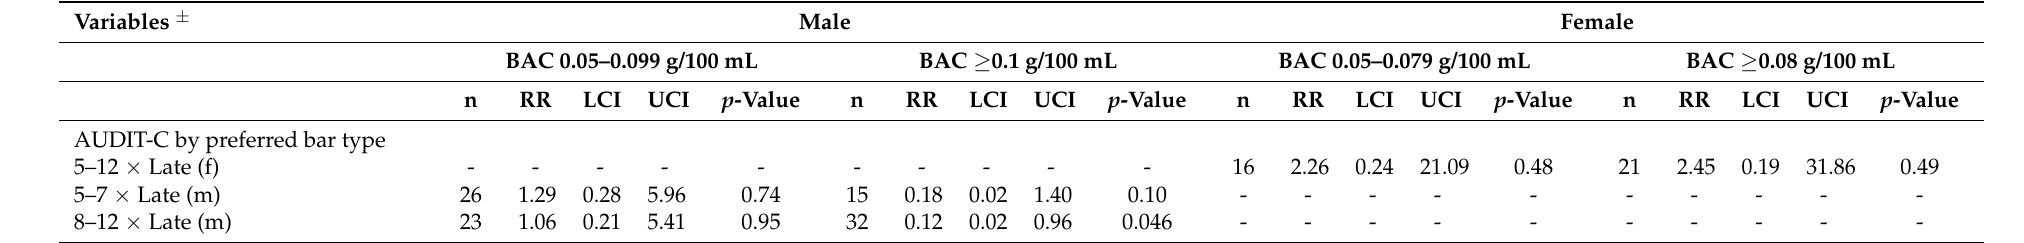
Table 3. Gender-specific multinomial logistic regression models: Two-way interaction effect between AUDIT-C and preferred bar type (standard vs. late) on BAC adjusting for survey and participant characteristics ±